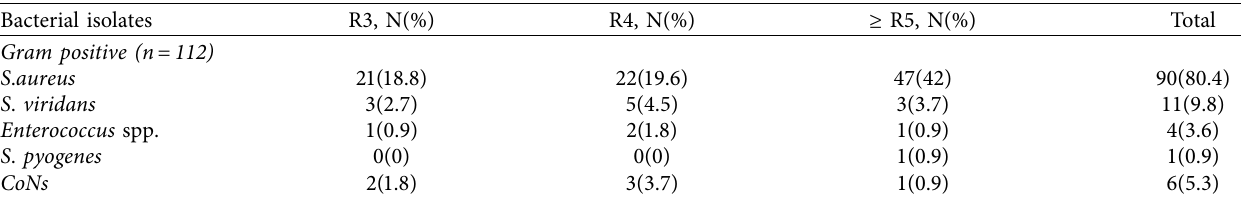
Table 6: Multidrug-resistant patterns for Gram-positive and Gram-negative bacterial isolates at University of Gondar Comprehensive Specialized Hospital, Northwest Ethiopia, 2021. Bacterial isolates Gram positive (n � 112) S .